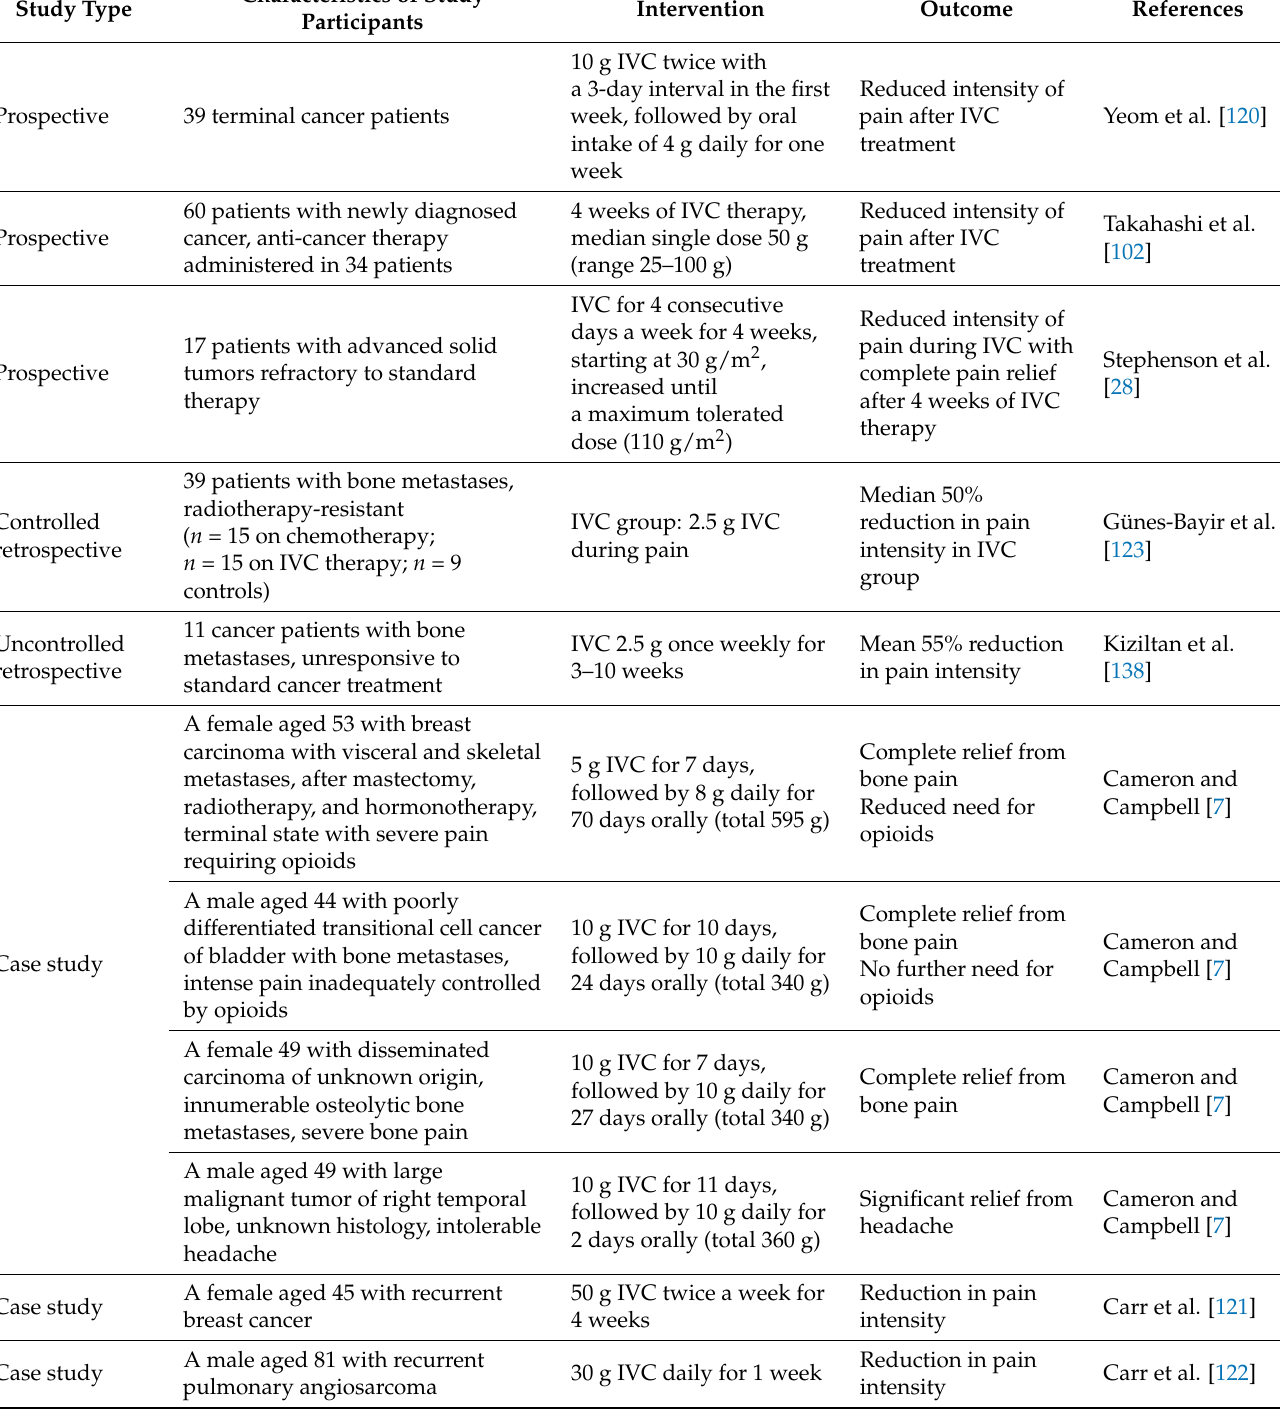
Table 2. Effect of high-dose intravenous vitamin C (IVC) on pain severity in cancer patients. Study